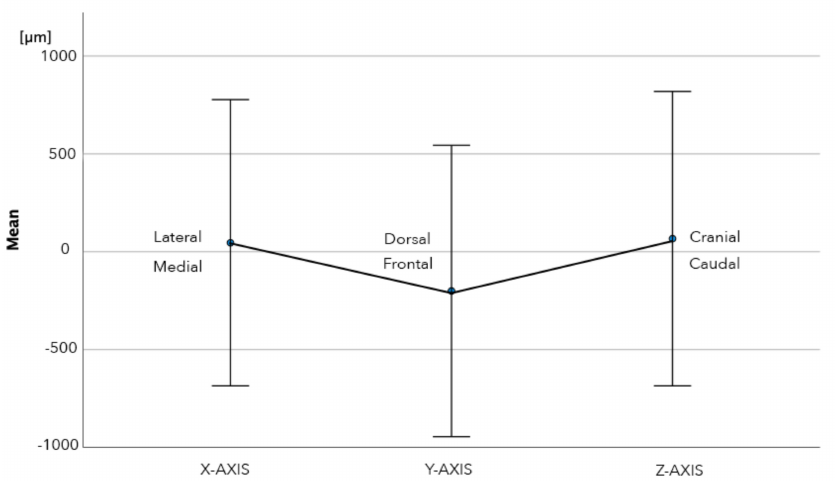
Figure 14. Linear deviation along X, Y and Y -axis between analog and digital bite registration technique. Mean and error bars are shown, with the error bars representing 1